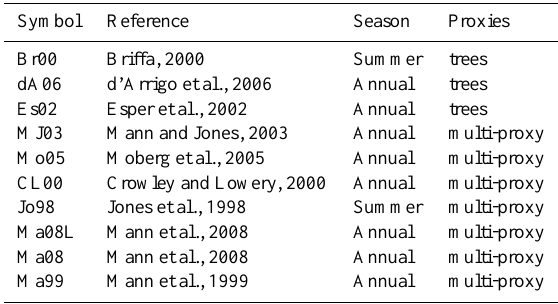
Table 1. The ten reconstructions used in this study, with target sea- son and proxy